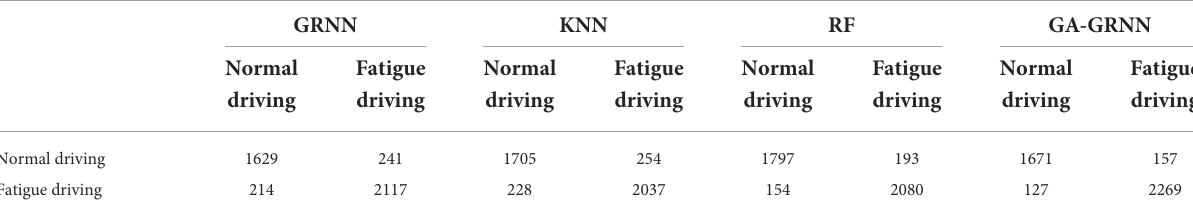
TABLE 3 Validation results of the model. Model